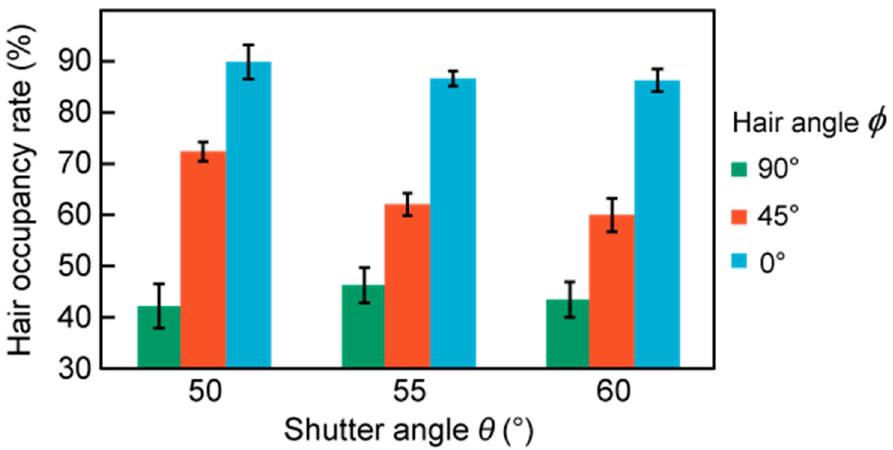
Figure 10. Hair occupancy ratio at different shutter angles and hair angles. The shutter angle and hair angle are defined in Figure 8.